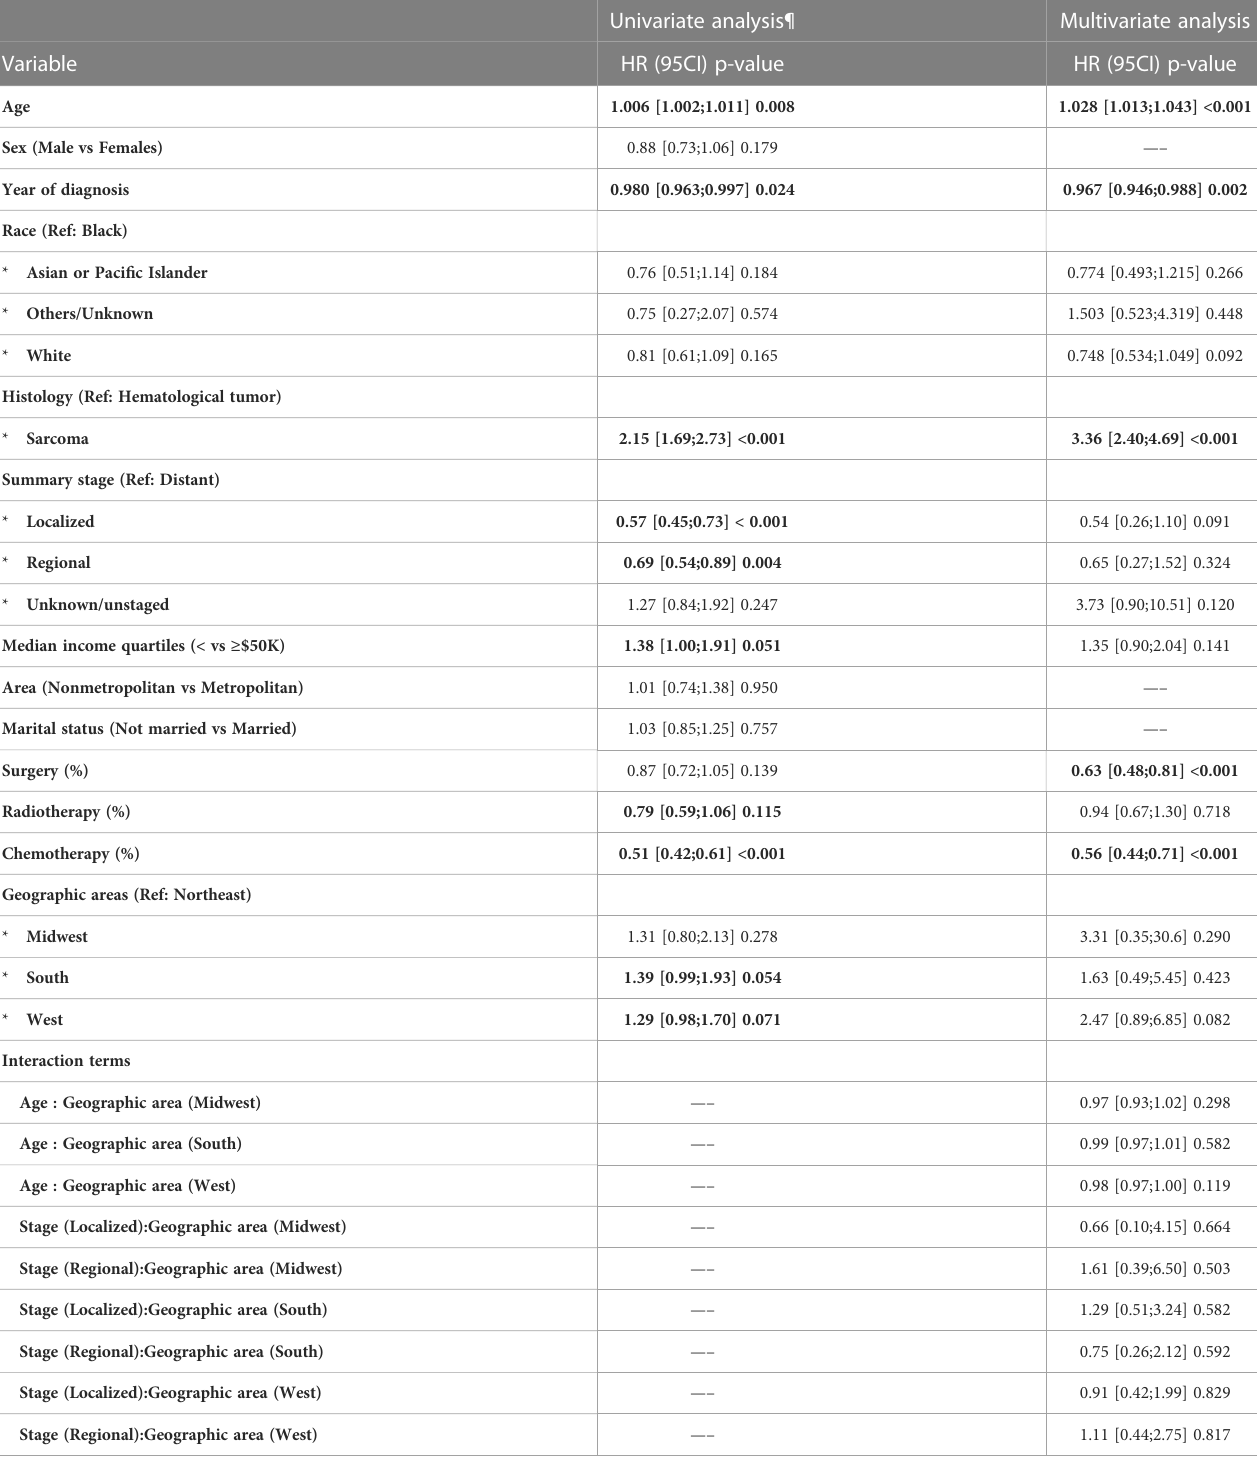
TABLE 2 Predictors of late overall mortality among the included cohort using Cox